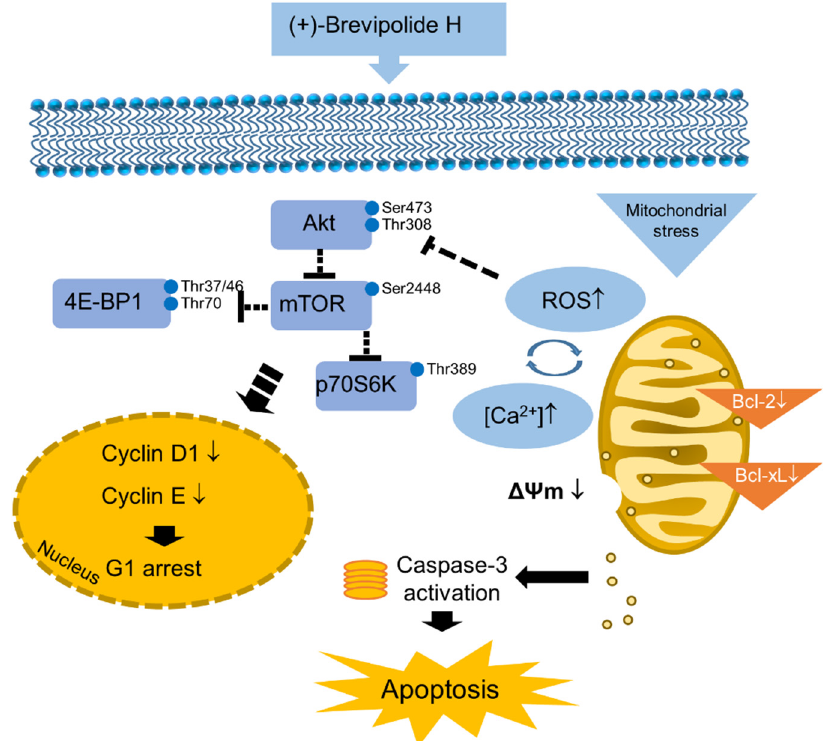
Figure 8. Signaling pathway of ( + )-brevipolide H in PC-3 cells. The ( + )-brevipolide H displays anticancer activity through mitochondrial stress in which the interplay between ROS production and increased cytosolic Ca 2 + levels takes place. The inhibition of both Bcl-2 and Bcl-xL plays a crucial role on mitochondrial dysfunction. Akt / mTOR / p70S6K pathway was suppressed followed by the downregulation of cyclin D1 and cyclin E in ( + )-brevipolide H-induced G1 checkpoint arrest. The cellular stress may ultimately induce apoptosis.